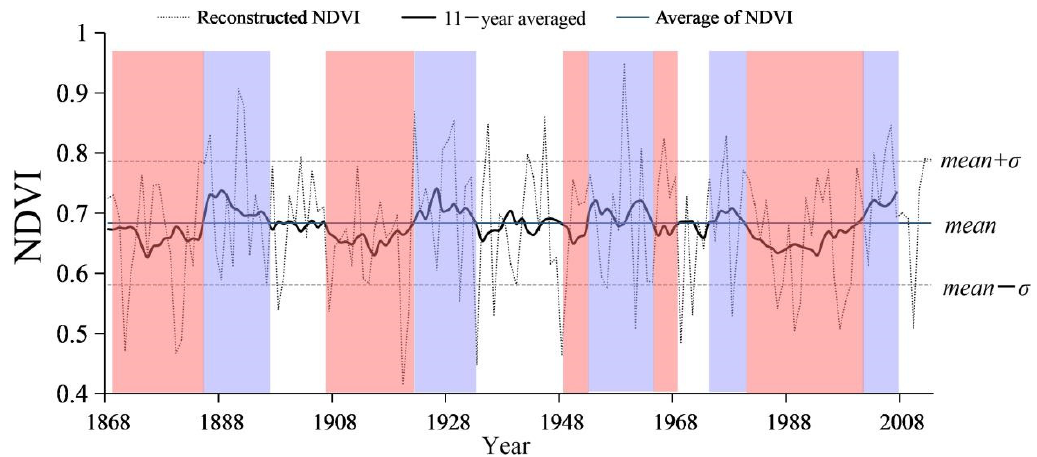
Figure 8. Variations of reconstructed annual maximum NDVI values of Mt. Taibai in AD 1849–2013. Blue bars are the dense vegetation-coverage periods, and the pink bars represent the sparse vegetation coverage periods according to the reconstructed curve from this paper.